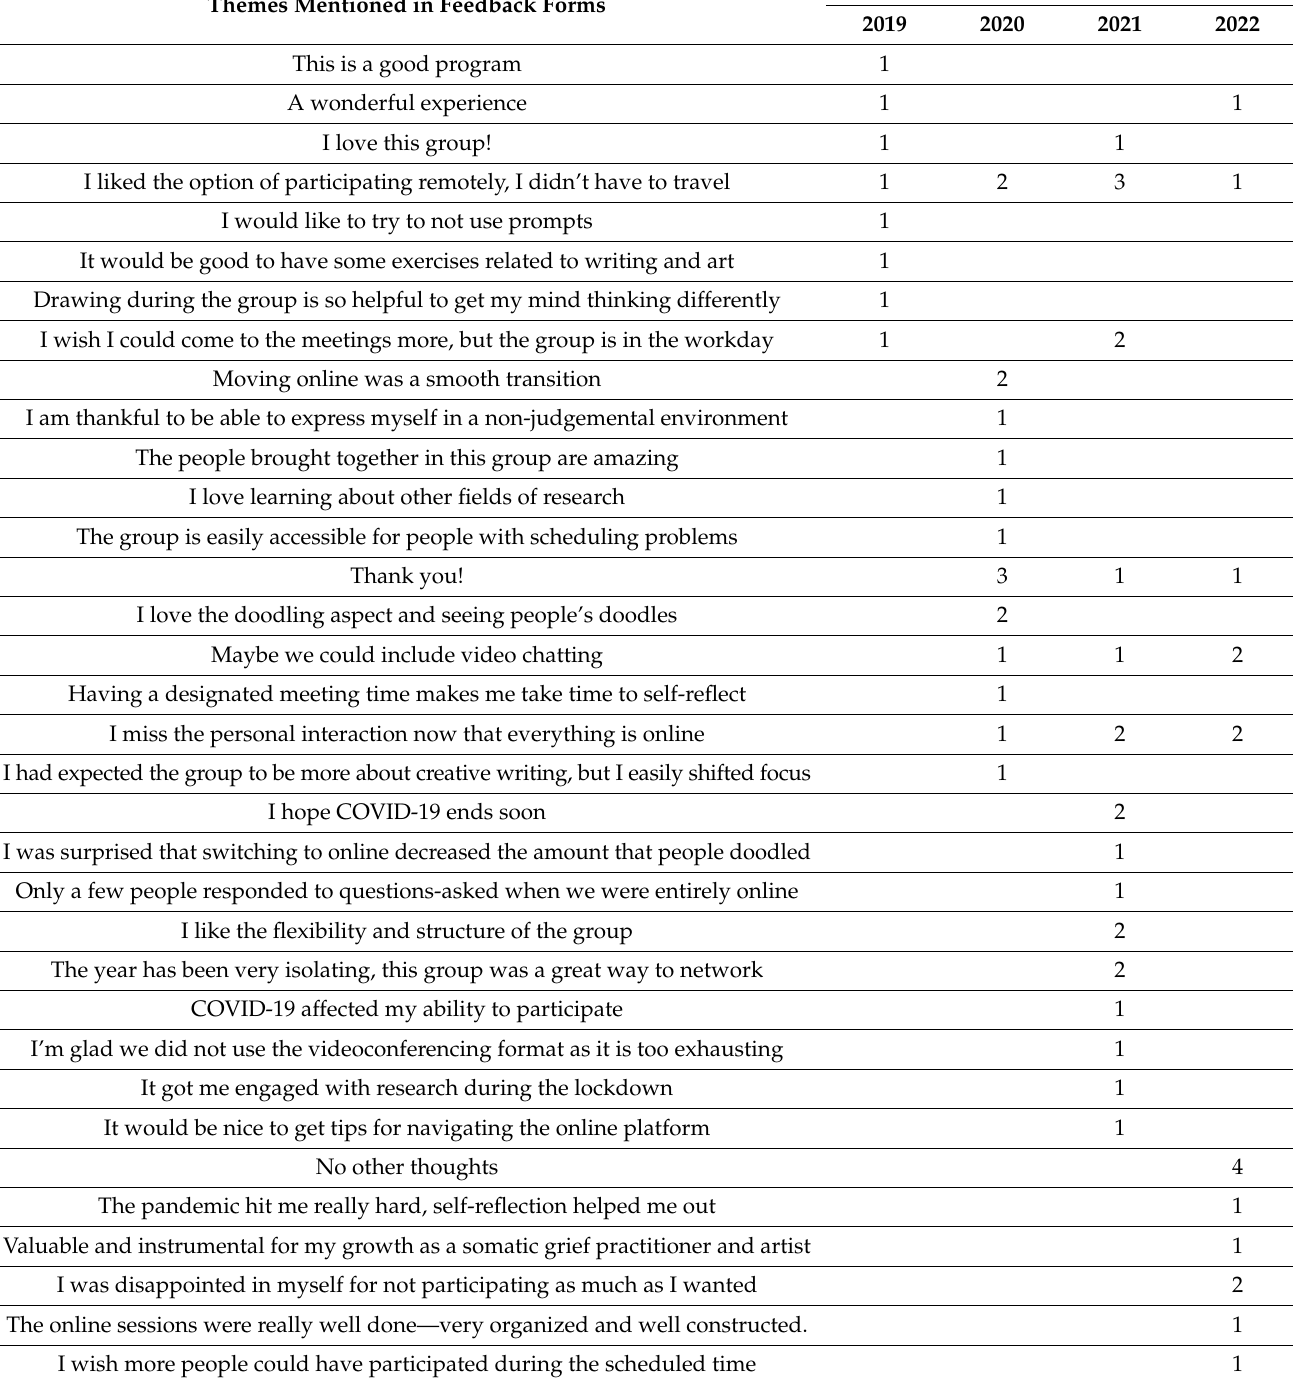
Table 5. Themes Mentioned in Responses Provided on the April Feedback Forms to “Do You Have Other Thoughts/Comments on Your Experience as a Participant in the HeNReG this Term (Especially as a Result of COVID-19)?” for Each of the Four Most Recent Academic Years in Order of Receipt of Feedback Forms from Group